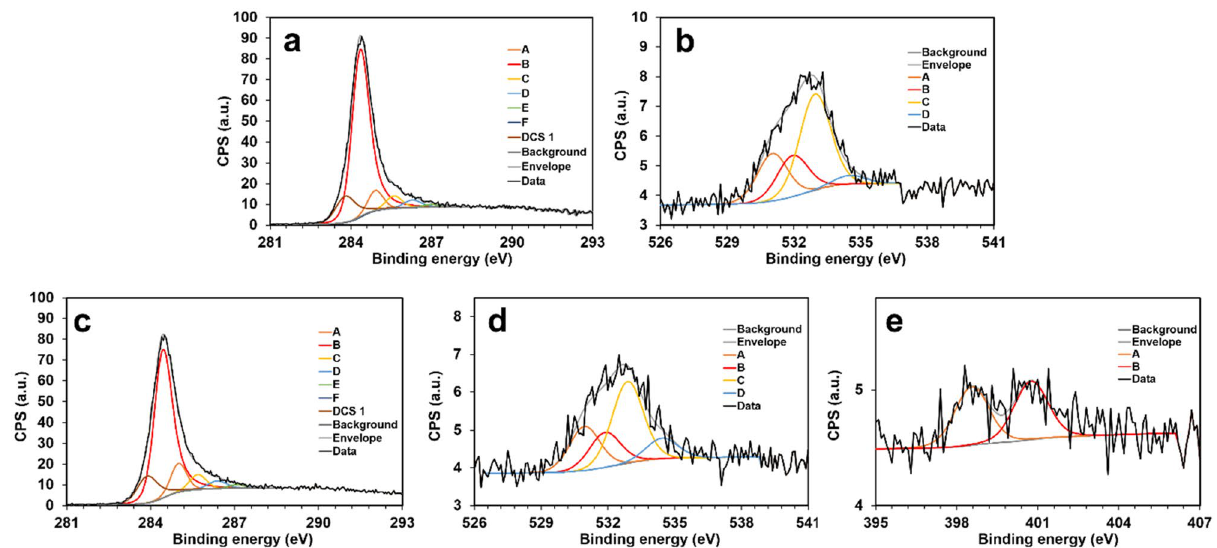
Figure 5. XPS spectra of the ( a ) RF-CNO-C (C 1 s), ( b ) RF-CNO-C (O 1 s), ( c ) RFM-CNO-C (C 1 s), ( d ) RFM-CNO-C (O 1 s), ( e ) RFM-CNO-C (N 1